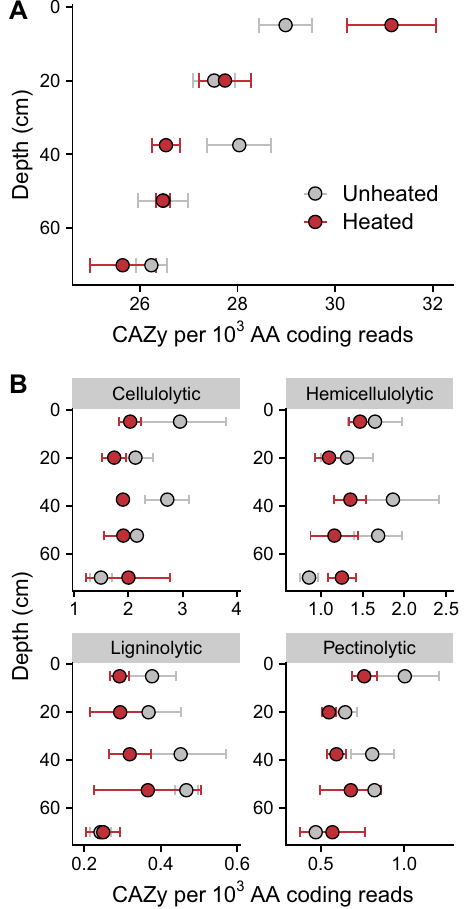
Fig. 5 Distribution and composition of carbohydrate-active enzymes (CAZy) genes throughout heated and unheated soil pro fi les. Total abundance of CAZy genes ( A ) and abundance of functionally classi fi ed CAZy genes ( B ) corrected by amino acid (AA) coding reads across heating treatments and depths. Error bars represent standard error of the mean ( n =